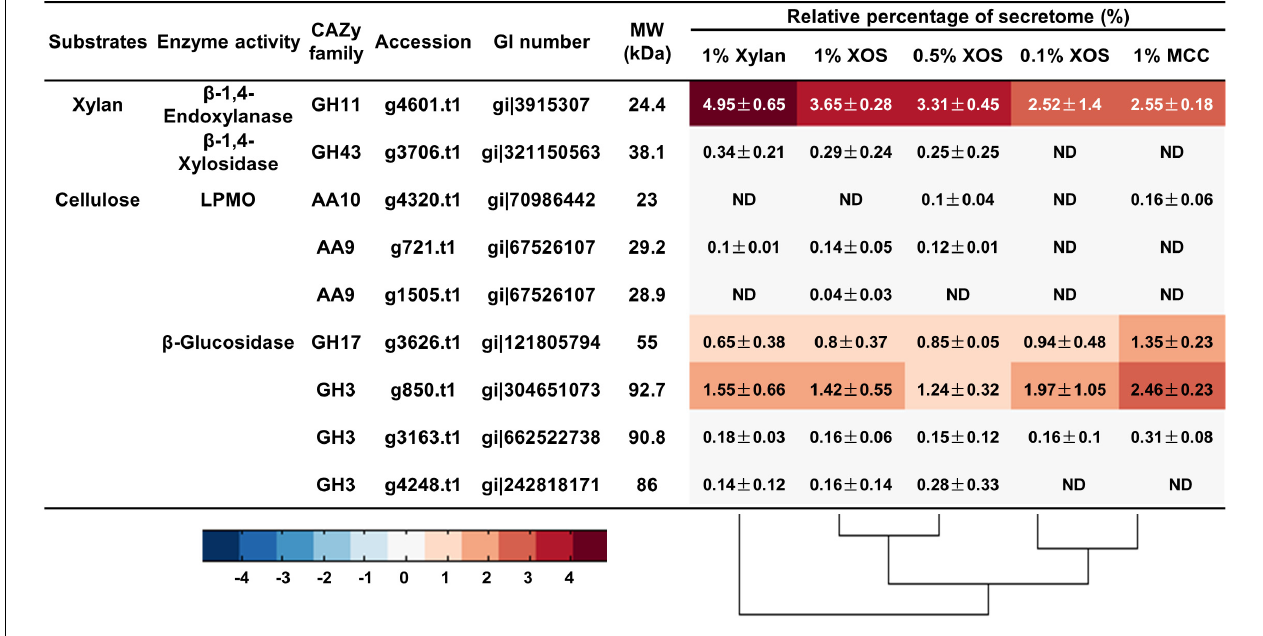
FIGURE 5 | The relative quantities of xylan- and cellulose-degrading proteins in the secretome of T. lanuginosus grown on different carbon sources. MCC, microcrystalline cellulose; XOS, xylo-oligosaccharide; ND, not